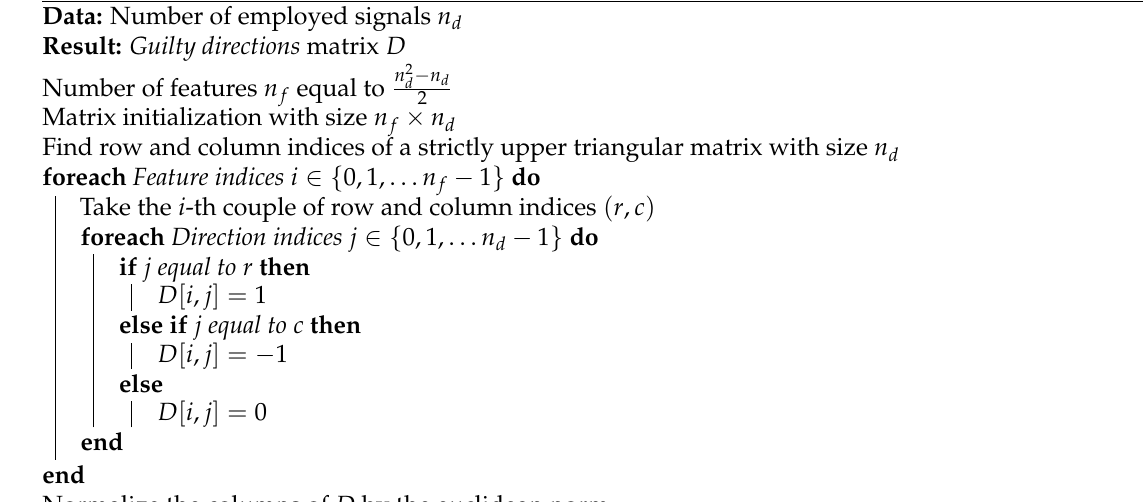
Algorithm 1 Algorithm for the creation of the guilty directions matrix.